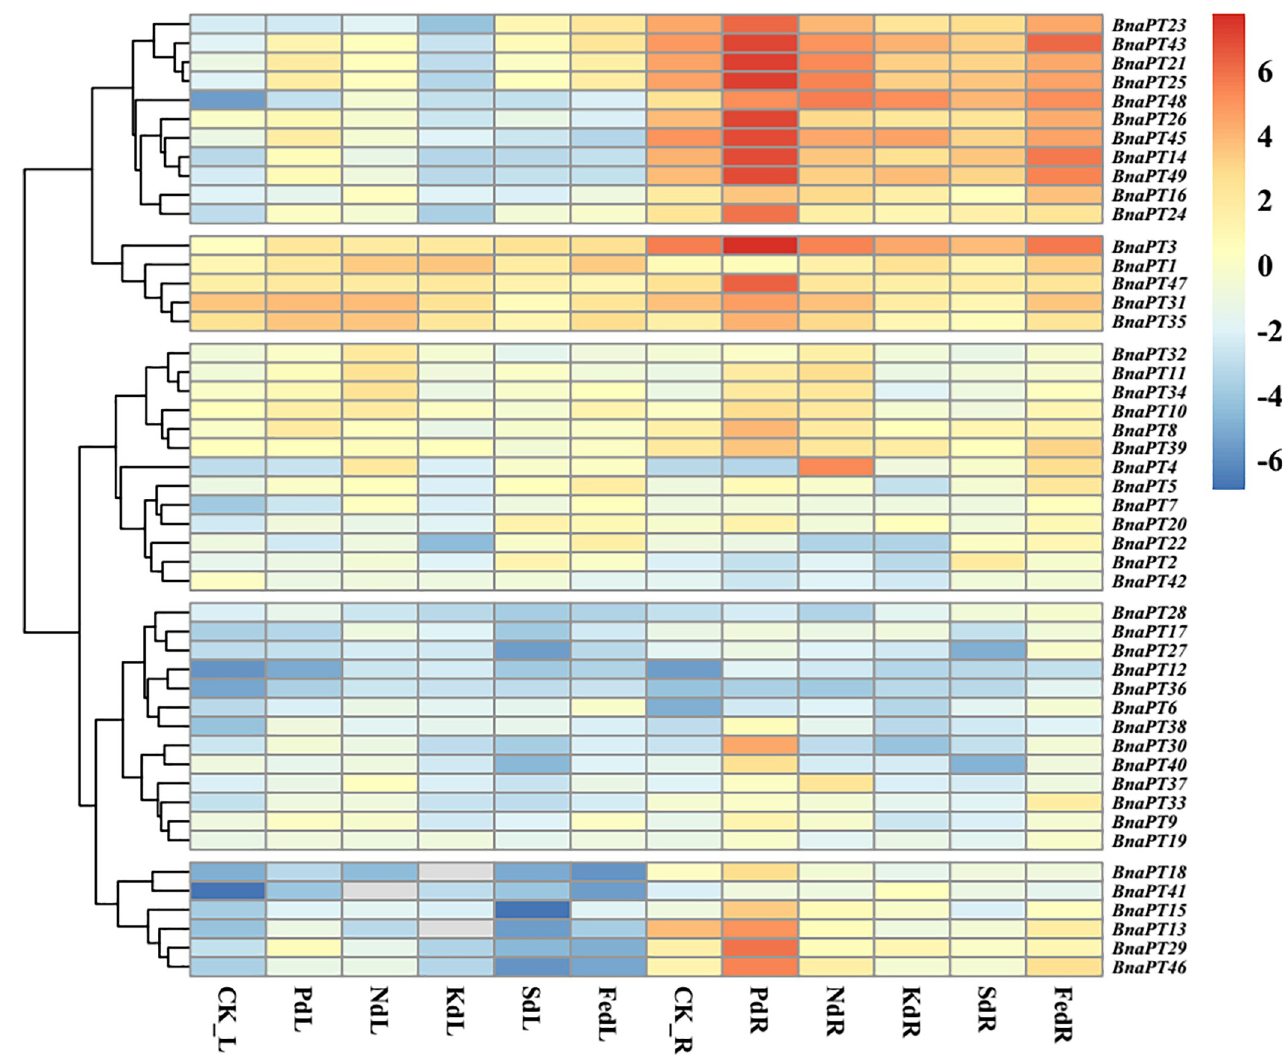
Fig 4. Expression profiles of the PHT1 family genes in the leaves and roots of Brassica napus under various nutrient stress conditions. Seedlings of 14 days old were exposed to various nutrient deficiency environments for six days. The fully expanded leaf and roots were sampled separately for RNA extraction. L, leaf. R, roots. CK, full strength Hoagland’s solution. Pd, phosphorus deficiency. Nd, nitrogen deficiency. Kd, potassium deficiency. Sd, sulfur deficiency. Fed, iron deficiency. The color scale is shown on the right side. Gray box indicates data undetected. Heat map of gene expression profiles was generated using pheatmap package in R after data